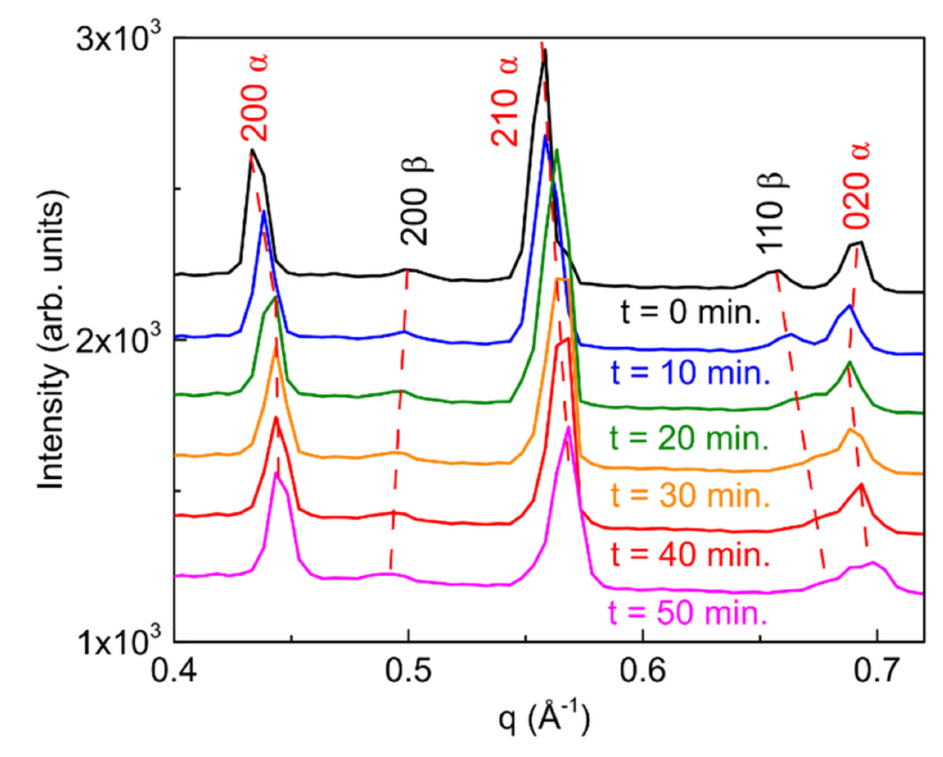
Figure 11. Integrated scans along the Debye-Scherrer rings obtained from selected 2D-GIXD images collected during in-situ annealing for the (PRSH)PbI 3 DMF-only sample investigated in Figure S12. The dotted lines are guides to the eyes highlighting the shift of the diffraction peaks upon